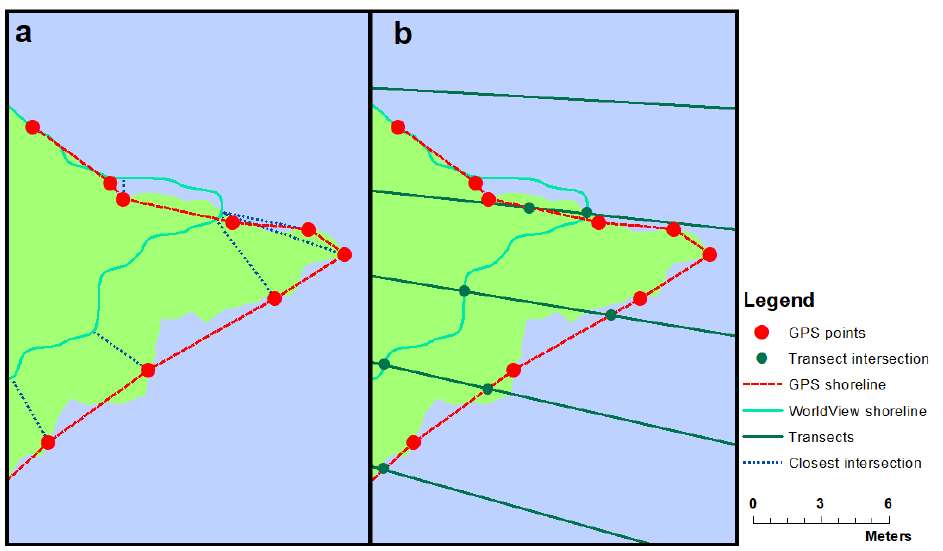
Figure 2. Differences between shoreline from WorldView satellite imagery and field-based surveys from Real-time Kinematic Global Positioning System (GPS) are estimated in two ways: ( a ) the distance between the GPS point and the nearest WV shoreline vector, and ( b ) the distance between the GPS approximated shoreline (by connecting the points) and the WVS using the intersection along transects.